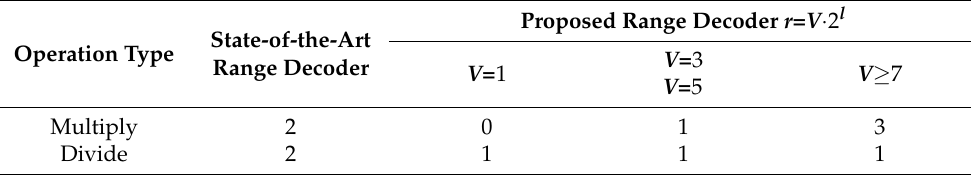
Table 5. Number of multiplication and division operations per decoded symbol for Total (cid:54) = 2 w 3 .